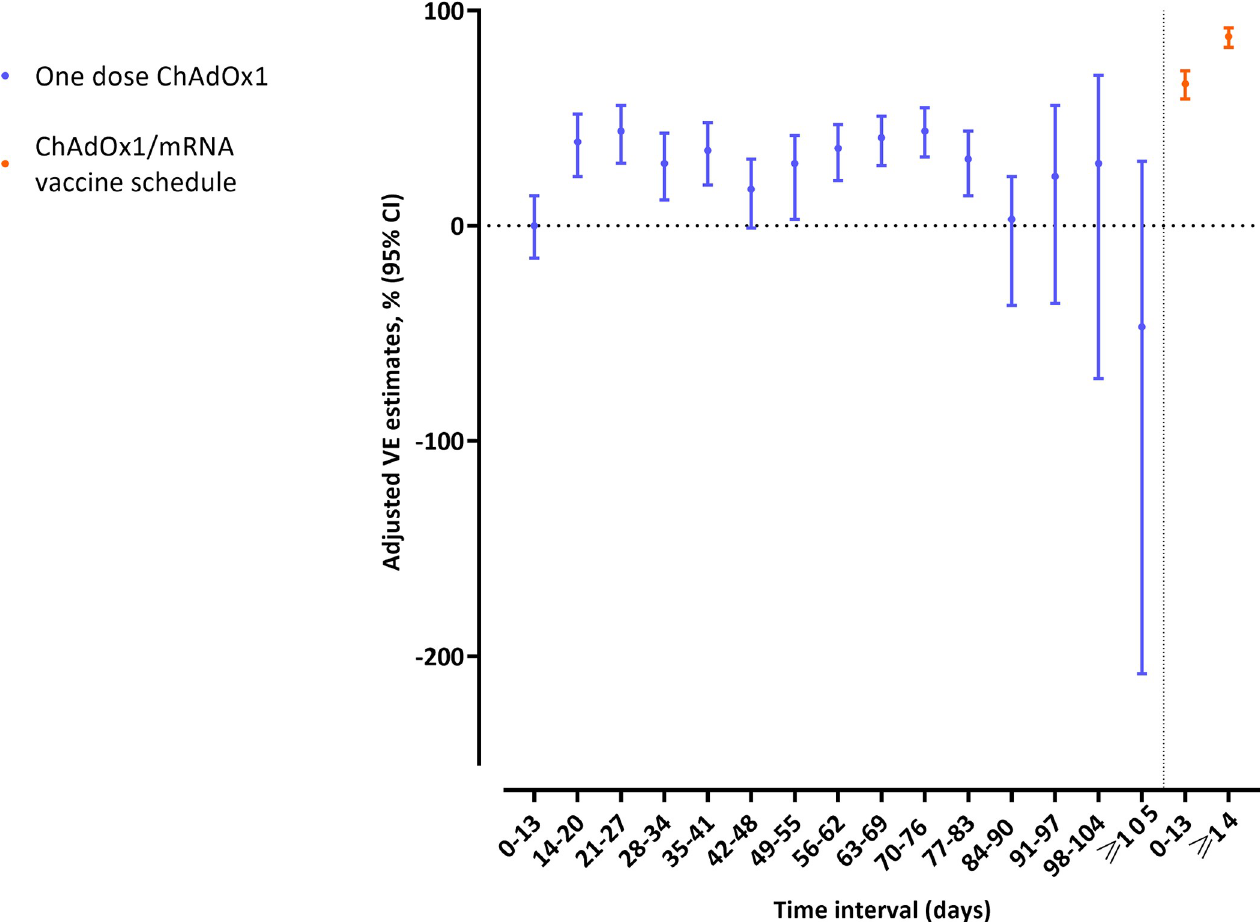
Fig 3. Adjusted VE estimates against RT-PCR SARS-CoV-2 infection of the first dose of the ChAdOx1 vaccine and the ChAdOx1/mRNA vaccine schedule. Each dot illustrates the estimated VE and the bars show the accompanying 95% CI. CI, confidence interval; RT-PCR, reverse transcription polymerase chain reaction; SARS-CoV-2, Severe Acute Respiratory Syndrome Coronavirus 2; VE, vaccine effectiveness.